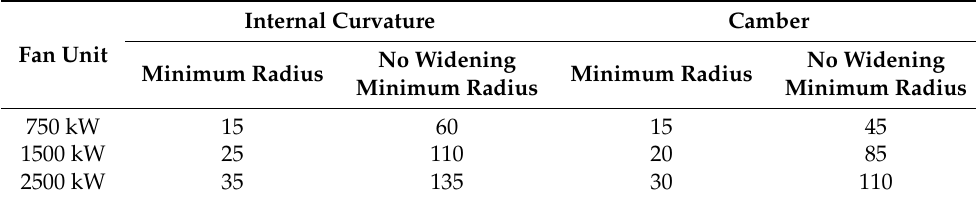
Table 2. Minimum radius with a widening limit of 10 m